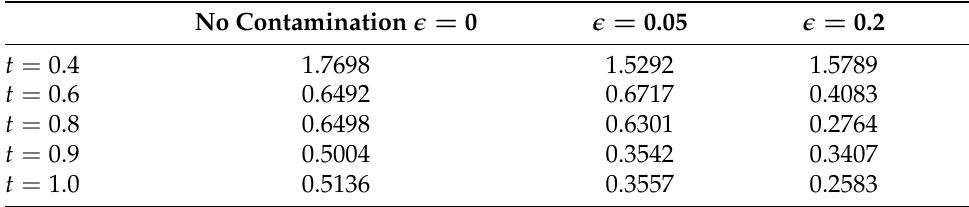
Table 2. Relative errors of the VOM+SAD approximation, in %.